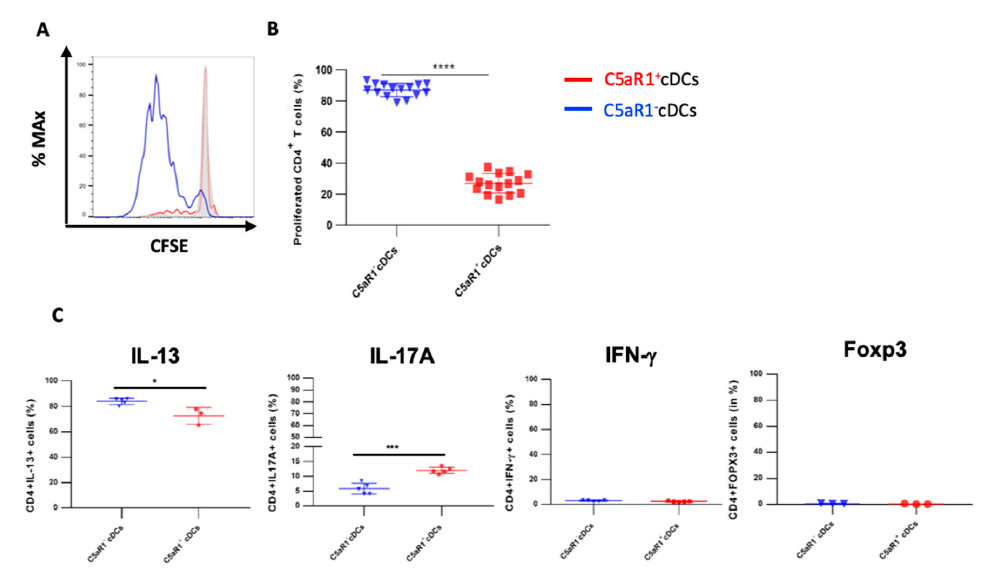
Figure 2. Proliferation and di ff erentiation of OVA-transgenic CD4 + T cells in response to co-culture with OVA-pulsed C5aR1 + or C5aR1 − cDCs. WT BALB / c mice were treated once with a combination of HDM / OVA (100 µ g / 40 µ g) i.t. C5aR1 + and C5aR1 − CD11b + cDCs from WT mice were FACS-purified from digested lung tissue 24 h after immunization. Both cell populations were co-cultured with (20 ng / mL) for four days. ( A ) Histogram showing the CFSE signal in OVA-specific TCR Tg CD4 + T